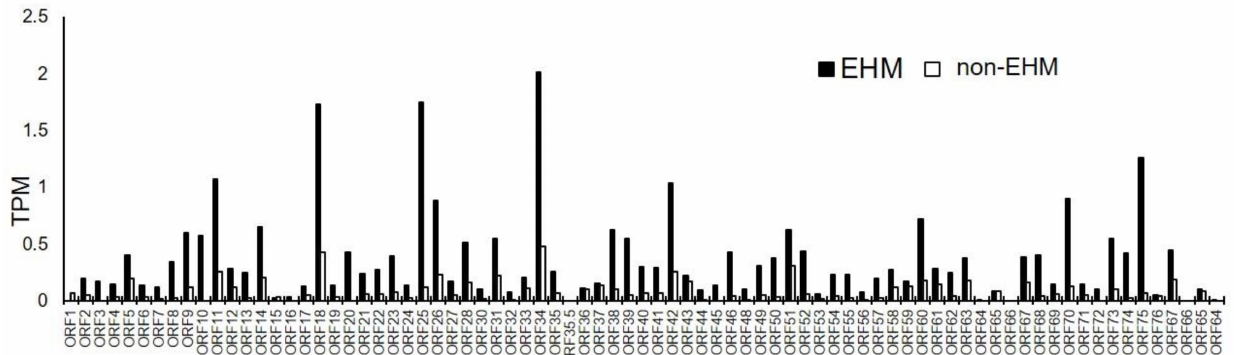
Figure 11. Normalized counts of viral genes post EHV-1 challenge. Data represents the average transcripts per million (TPM). The gray line is non-EHM horses and the black line is EHM